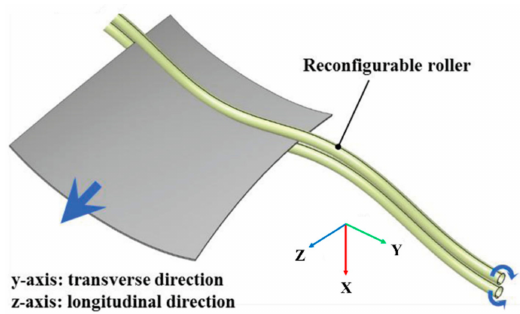
Figure 1. Schematic illustration of the flexibly-reconfigurable roll forming (FRRF)